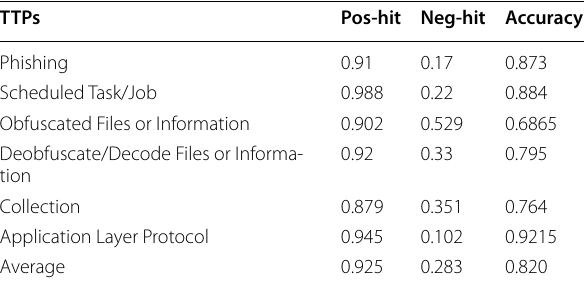
Table 8 Matching rate of TTP keywords in the dataset